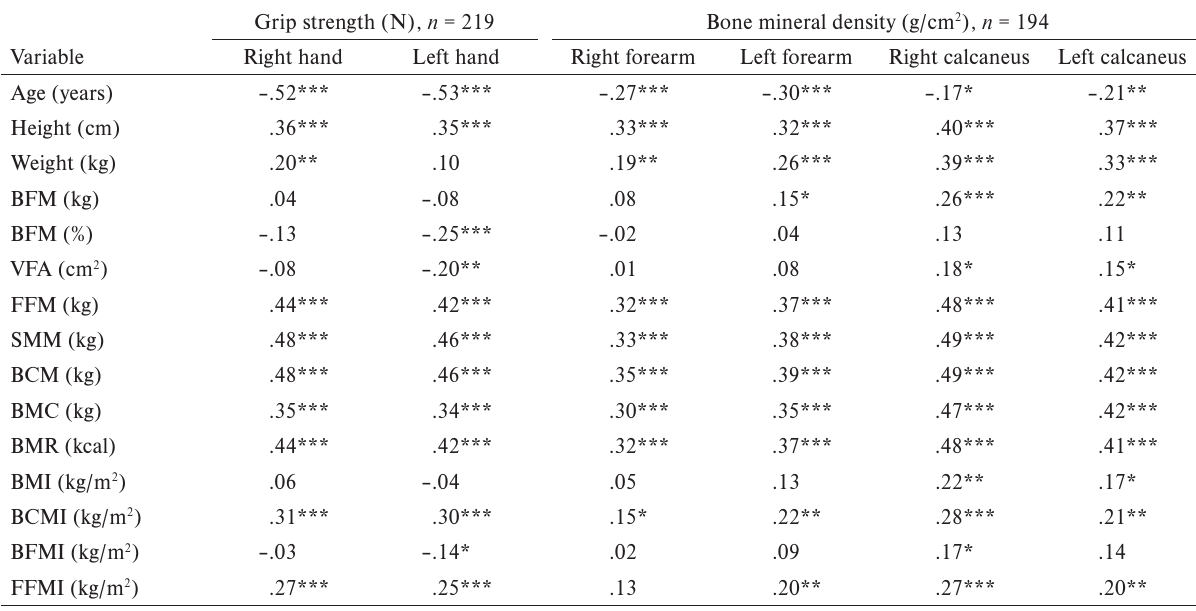
The relationship between selected parameters of body composition, muscular strength in the hand flexors and bone density using Pearson correlation coefficient